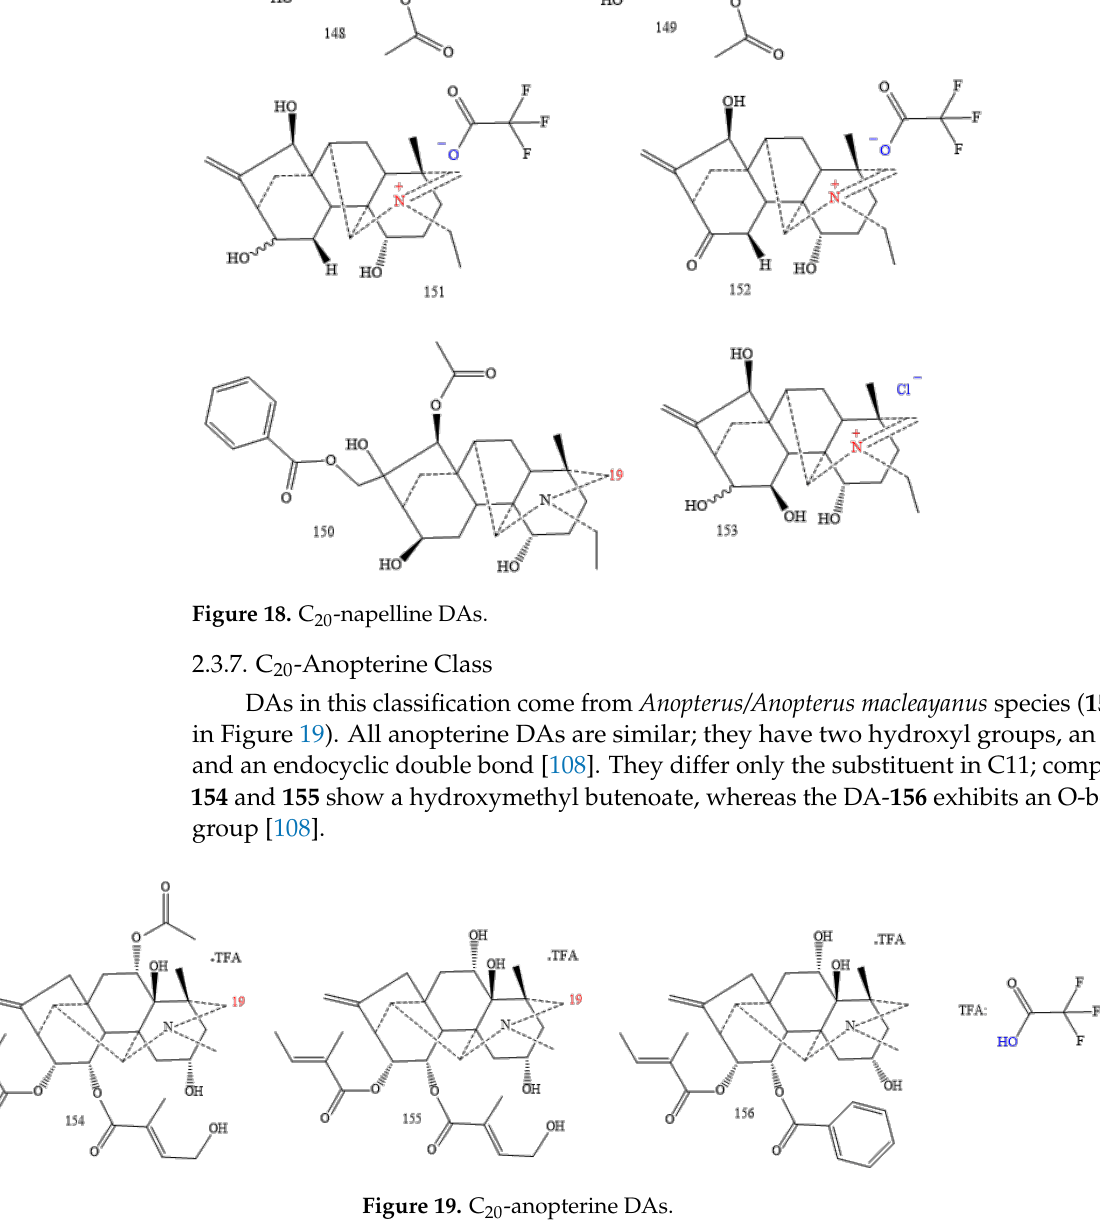
Figure 19. C 20 -anopterine DAs.